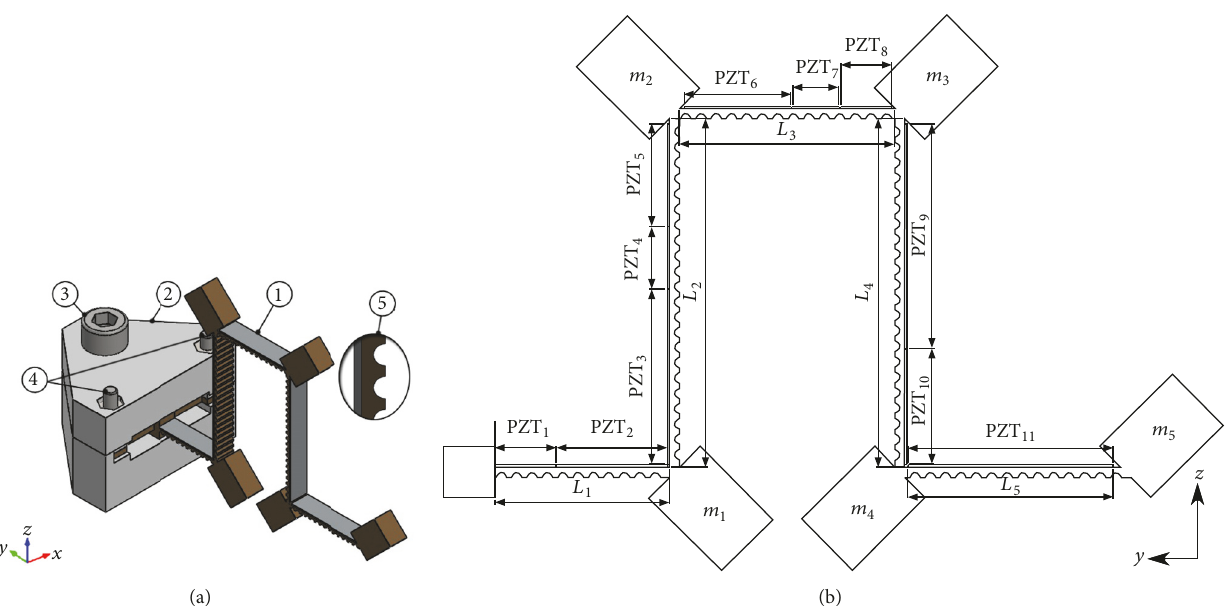
Figure 1: Schemes of the harvester; (a) isometric view of the harvester; 1, bolt for clamping to the host structure; 2, housing plate; 3, body of the harvester made of C17200 beryllium bronze; 4, bolts for harvester clamping to the housing plate; 5, cross-sectional design of the harvester; (b) principle scheme of the harvester; PZT 1 –PZT 11 , soft piezoceramic made of PIC255; 𝐿 1 – 𝐿 5 , lengths of cantilevers; 𝑚 1 – 𝑚 5 , seismic masses.